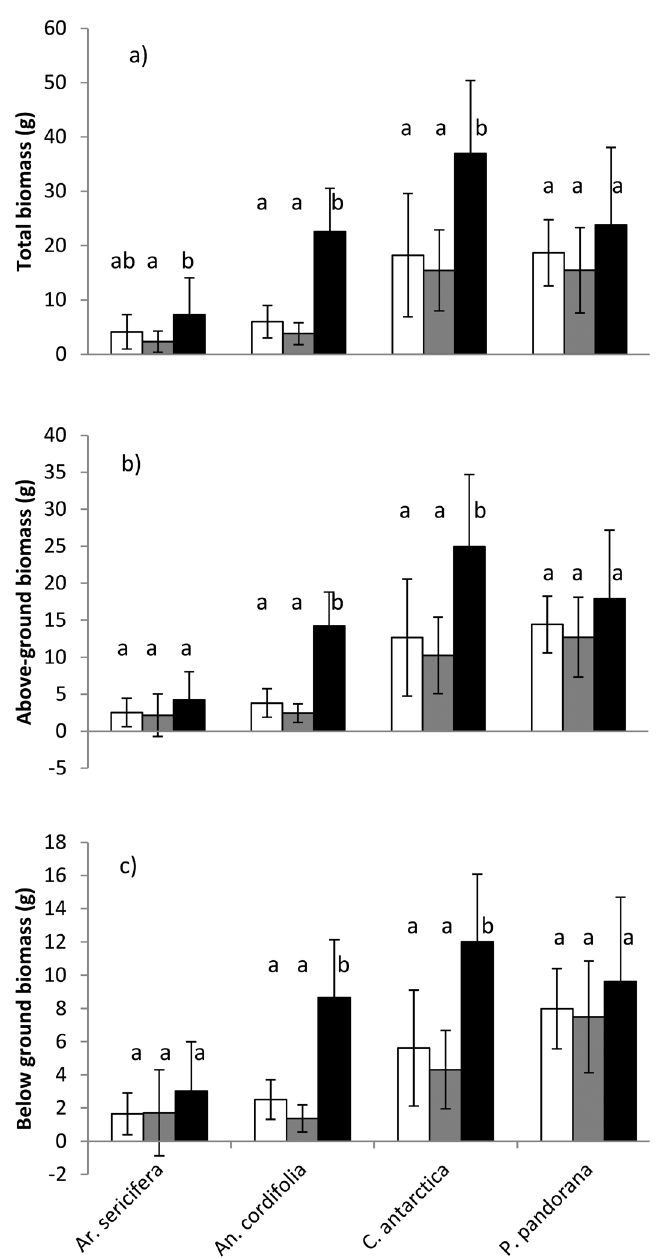
Figure 4. Average a total biomass b above-ground biomass c below-ground biomass of two invasive lia- nas, Araujia sericifera, Anredera cordifolia, and two native lianas, Cissus antarctica and Pandorea pandorana grown under different competition treatments: alone (white bars), with a conspecific (grey bars) and with G. semiglauca (black bars). Letters above each group of bars are results from Tukeys multiple comparison tests where different letters represent significant differences within each set of